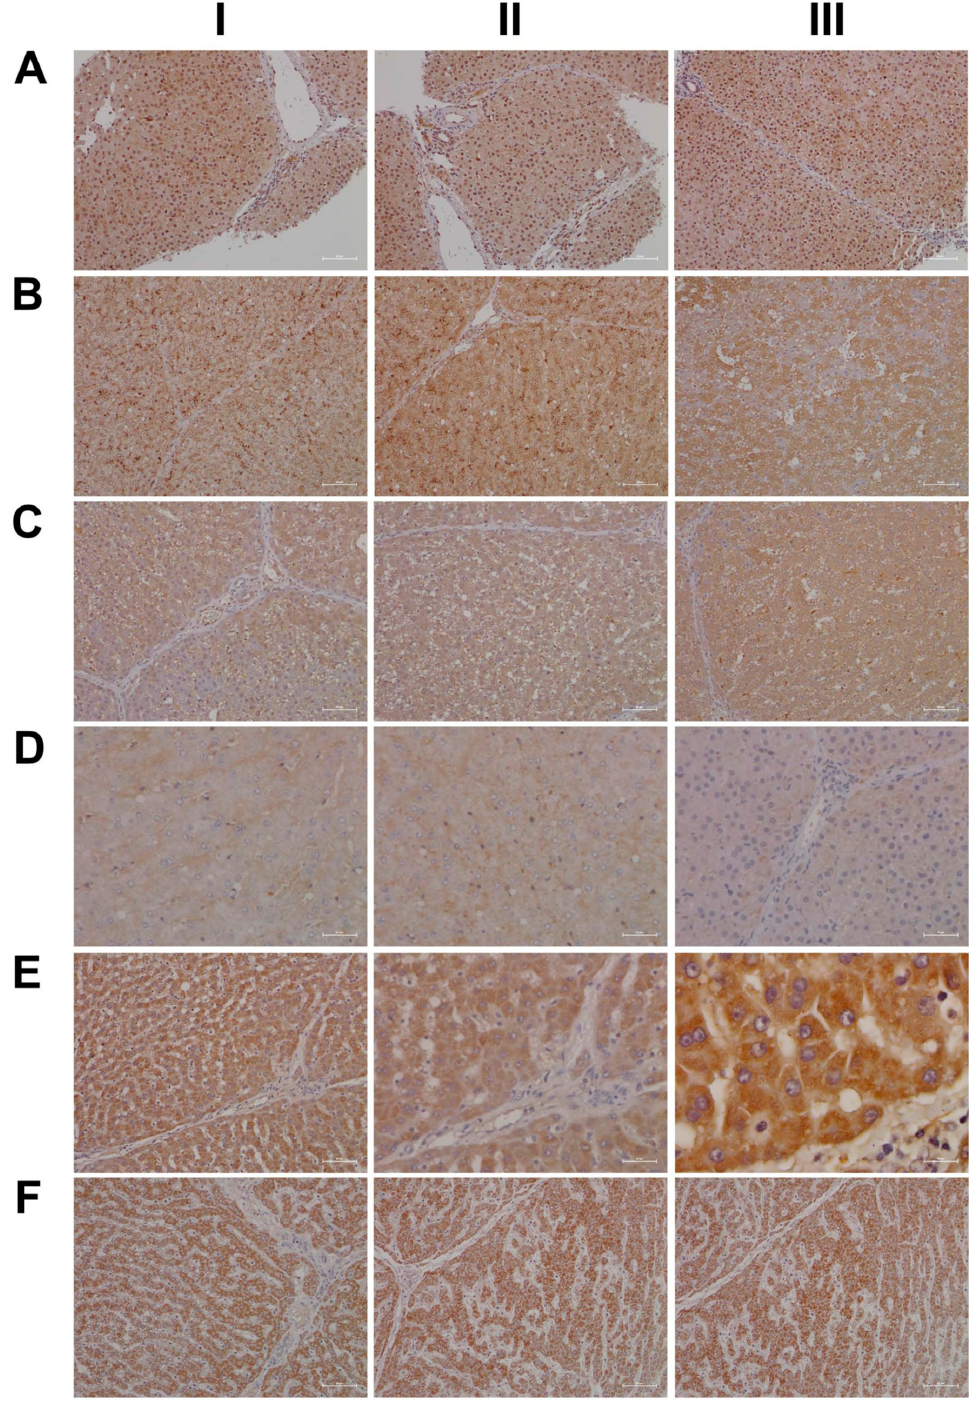
Figure 17. Immunohistochemistry of corticosteroid binding globulin and the glucocorticoid receptor in liver sections of control and diclofenac-treated animals after daily dosing for 28 days. In the circulation, cortisol is primarily transported by the corticosteroid binding globulin (CBG), and this protein is mainly synthesized in the liver. Only free cortisol binds to the glucocorticoid receptor (GR) and diffuses across the cell membrane and binds to the GR. Panel AI–III: Liver sections of three individual control animals. We observed slight to moderate cytosolic and nuclear staining of CBG. Panel BI–III: Diclofenac low-dose treatment caused marked increases in CBG, with a dust-like appearance in the sinusoids of treated animals. Additionally, BIII exemplifies the mosaic-like CBG